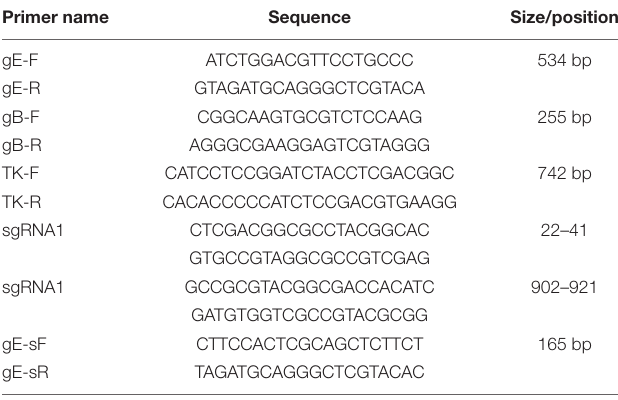
TABLE 1 | Primers for recombinant virus construction and detection.